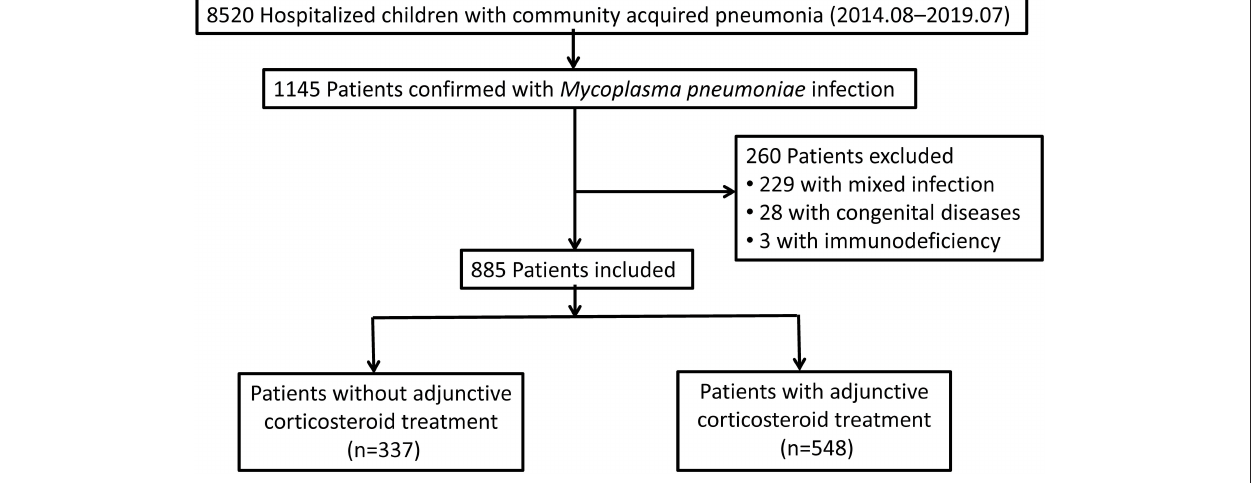
FIGURE 1 | Study flow